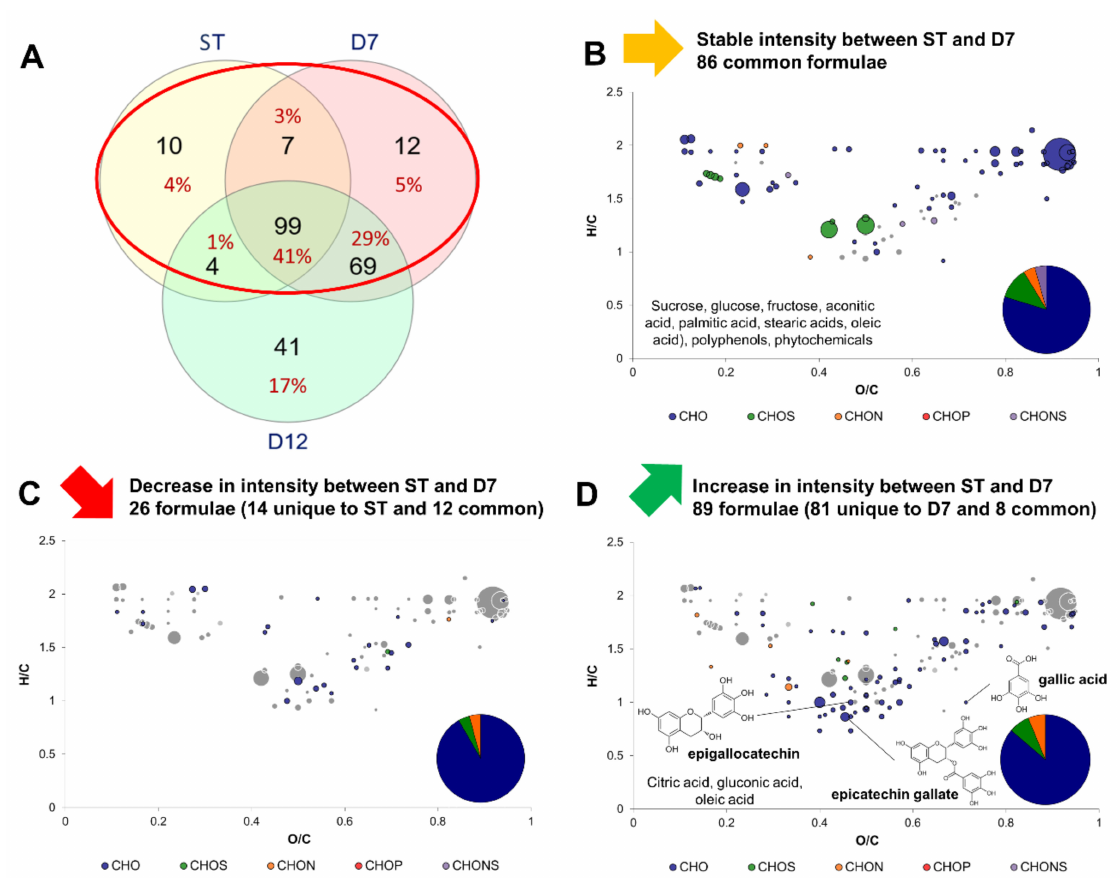
Figure 3. Change in composition between sugared teas (common formula between sugared black and green teas) and day 7 (D7) kombuchas (common formula between black and green tea kombuchas). ( A ) Venn diagram of formulae identified at each process step: Sugared tea (ST), day 7 (D7) and day 12 (D12) with focus on the comparison of ST with D7 (red circle). Van Krevelen diagrams and putative identities of ( B ) stable, ( C ) decreasing and ( D ) increasing formula between ST and D7. The surface of bubbles expresses relative formulae intensity. Core metabolites formulae (Figure 2B) are represented in the background in